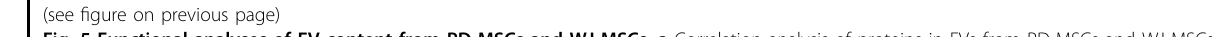
Fig. 5 Functional analyses of EV content from PD-MSCs and WJ-MSCs. a Correlation analysis of proteins in EVs from PD-MSCs and WJ-MSCs. Matrix was plotted using three replicates for each EV source. b PCA for samples shown in a . c GSEA pro fi le of EV protein content from PD-MSCs, WJ- MSCs, and iPSCs against epithelial-to-mesenchymal transition (EMT) signature genes. Proteins originated from both MSC EVs (PD and WJ) were assigned a mesenchymal phenotype, while proteins from iPSC EVs were assigned a pluripotent phenotype. d Heat map showing relative expression levels of proteins enriched in EMT GSEA plot ( c ). Red indicates high abundance, and blue indicates low-to-no abundance. e , f Distribution of normalized spectral counts expressed as Log 2 in four different sets of signature genes related to regeneration ( e ) and three related to cell cycle regulation ( f ) for EVs originated from PD-MSCs, WJ-MSCs, and iPSCs. g Wound healing assay results expressed as the mean percentage (%) of wound closure relative to time zero in two independent experiments± SE. a versus Without EVs ( p value <0.05); b versus Without EVs ( p value